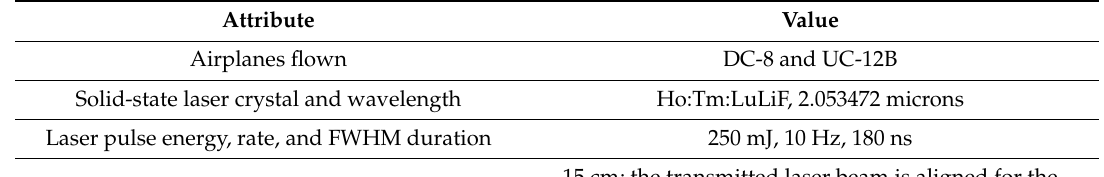
Table 2. DAWN Lidar Specifications.